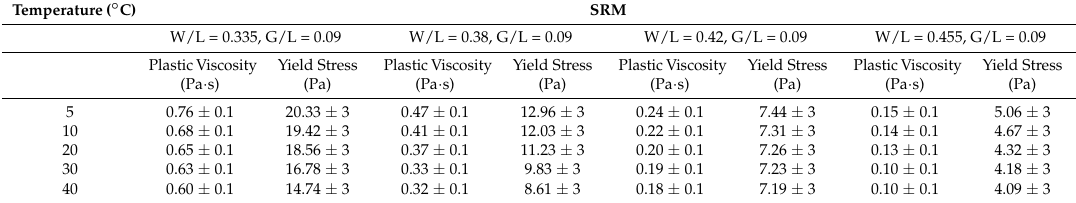
Table 2. The variation of the flow characteristics of SRM according to various temperatures. Temperature( ◦ C) SRM W/L = 0.335, G/L = 0.09 Yield Stress